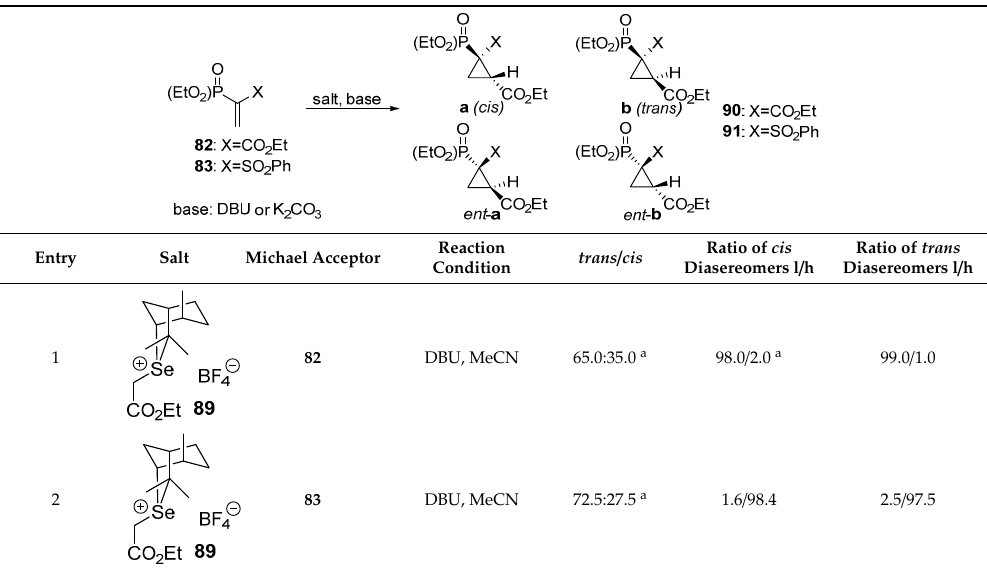
Molecules 2020 , 25 , x Table 5. Cyclopropanation reaction with selenonium salt containing the ethyl acetate substituent. Table 5. Cyclopropanation reaction with selenonium salt containing the ethyl acetate Table 5. Cyclopropanation reaction with selenonium salt containing the ethyl acetate substituent. Table 5. Cyclopropanation reaction with selenonium salt containing the ethyl acetate substituent.